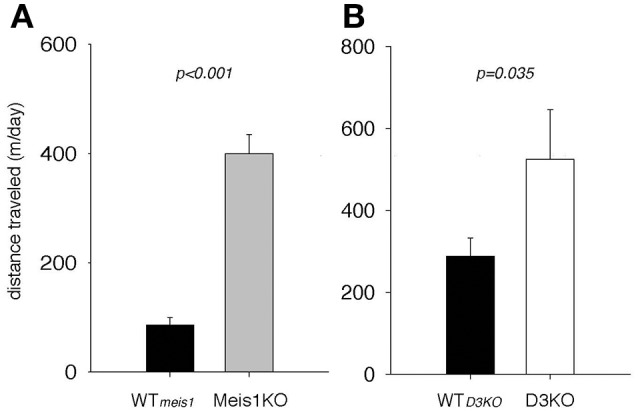
Spontaneous locomotor activities of Meis1KO and D3KO and their respective controls. (A) Meis1KO. Meis1KO displayed significantly increased locomotor activities per 24 h over their WT controls (WTMeis1). (B) Similar to Meis1KO, D3KO animals ran significantly longer distances per day over their controls (WTD3KO).